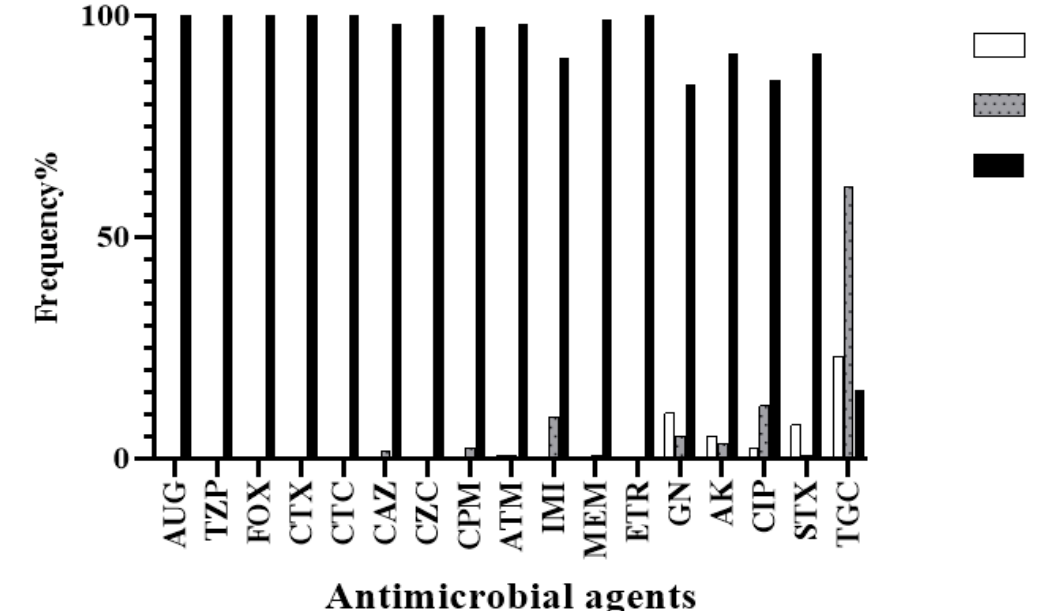
Figure 2. The frequencies of antimicrobial resistance of collected isolates to different antimicrobial classes. The frequencies of K. pneumoniae isolates resistance against β -lactams were very high (mostly 100%), while they were variable for non- β -lactam antimicrobials. S, Sensitive; I, Intermediate; R, Resistant. AUG, amoxicillin/clavulanic acid; TZP, piperacillin/tazobactam; FOX, cefoxitin; CTX, cefotaxime; CTC, cefotaxime / clavulanic acid; CAZ, ceftazidime; CZC, ceftazidime / clavulanic acid; CPM, cefepime; ATM, aztreonam; IMI, imipenem; MEM, meropenem; ETR, ertapenem; GN, gentamicin; AK, amikacin;